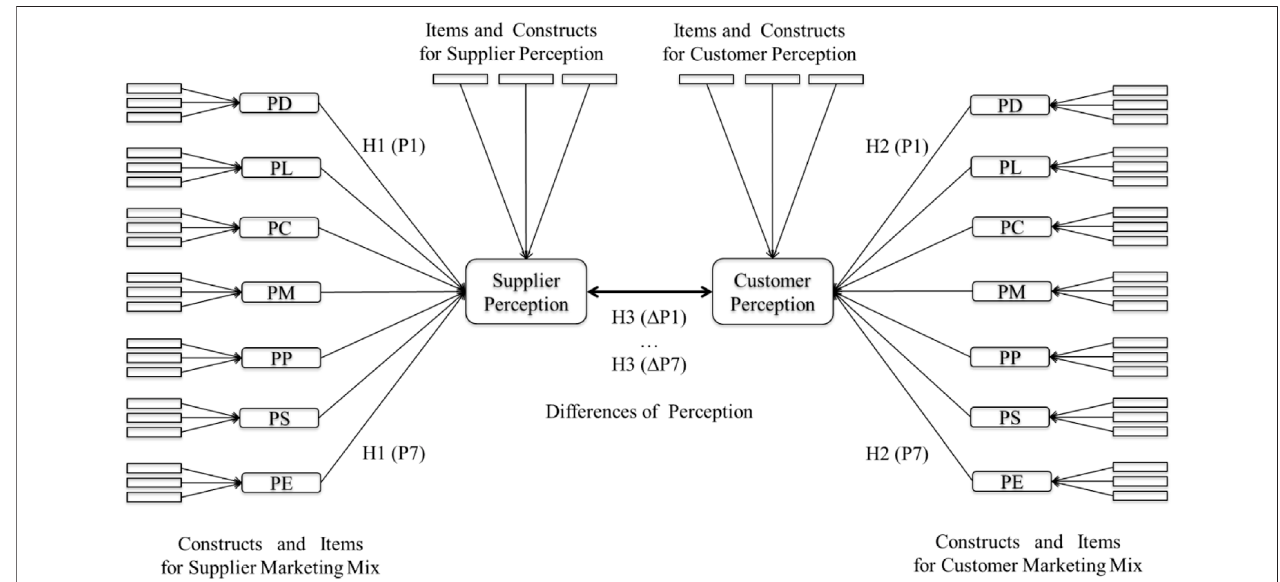
FIGURE 3 | Theoretical model of